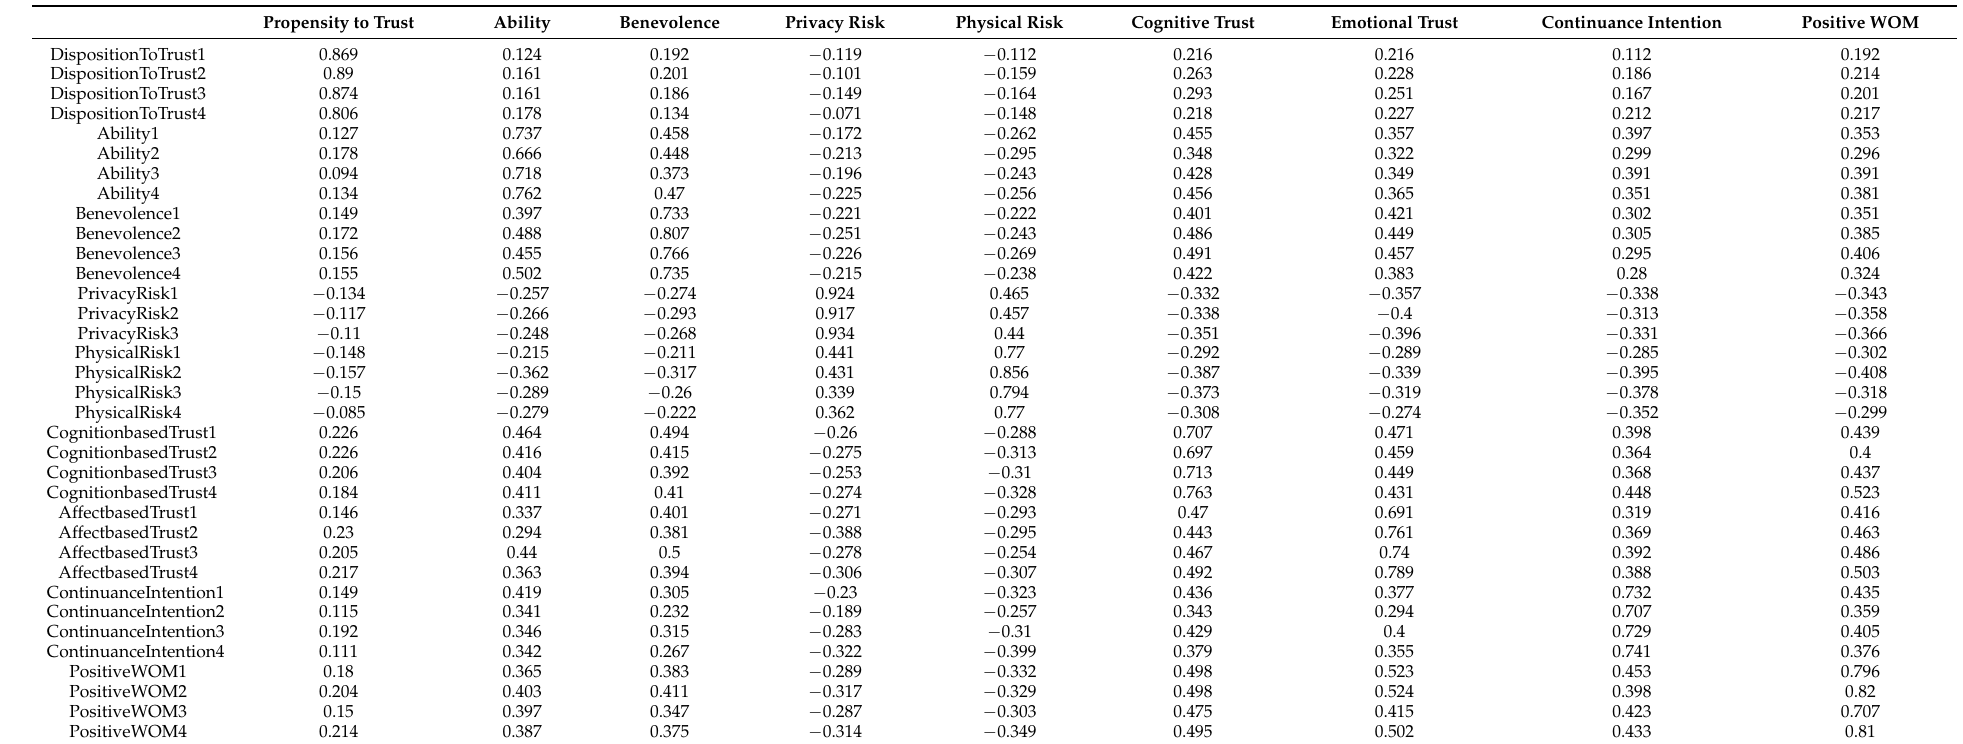
Table 4. Results of the discriminant validity (cross-loading